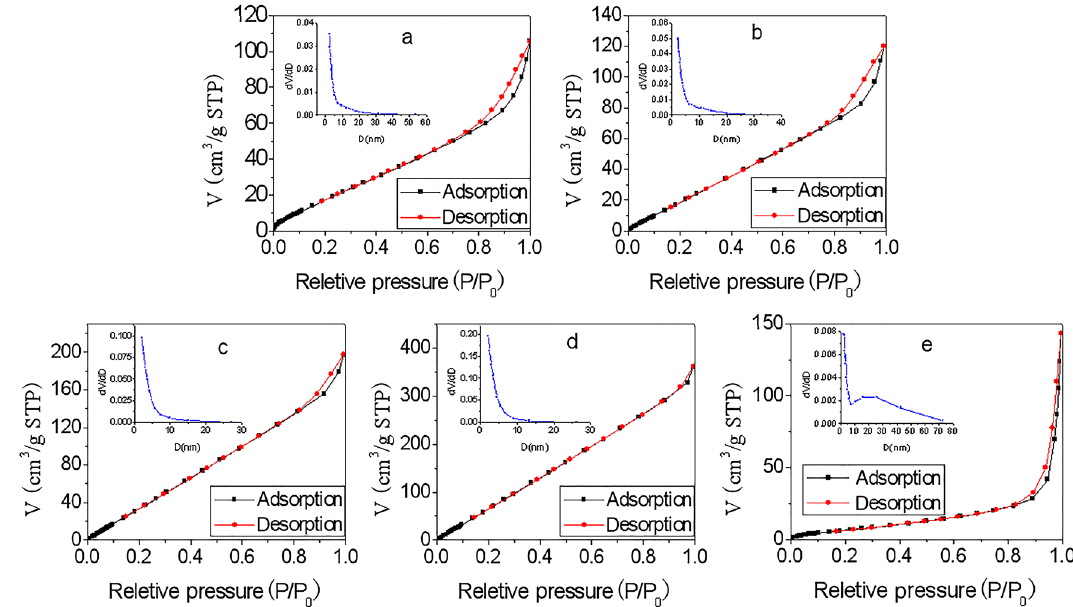
Figure 5. Isothermal adsorption and desorption curves (N 2 ) and pore size distributions (BJH desorption) [WG concentrations while preparation: ( a ) 2 mg/mL; ( b ) 4 mg/mL; ( c ) 6 mg/mL; ( d ) 8 mg/mL; ( e ) 10 mg/mL].